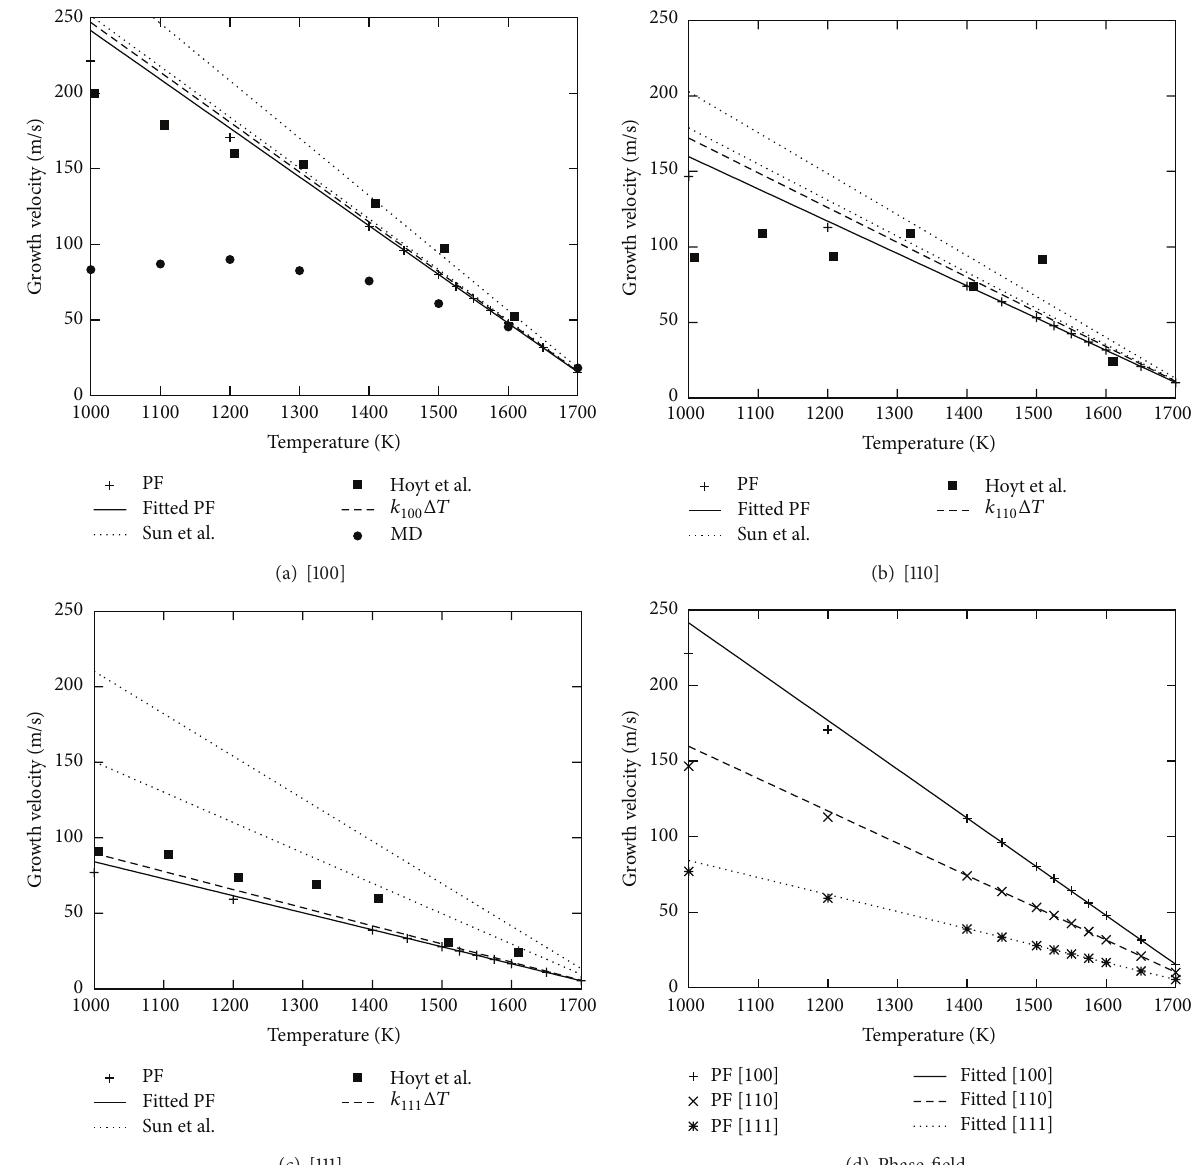
Figure 1: Growth velocity of a planar front at different temperatures for the interface orientations (a) [100], (b) [110], and (c) [111] in com- parison to molecular dynamic results. The values of the kinetic coefficient can be found in Table 1. (d) shows the phase-field results for all